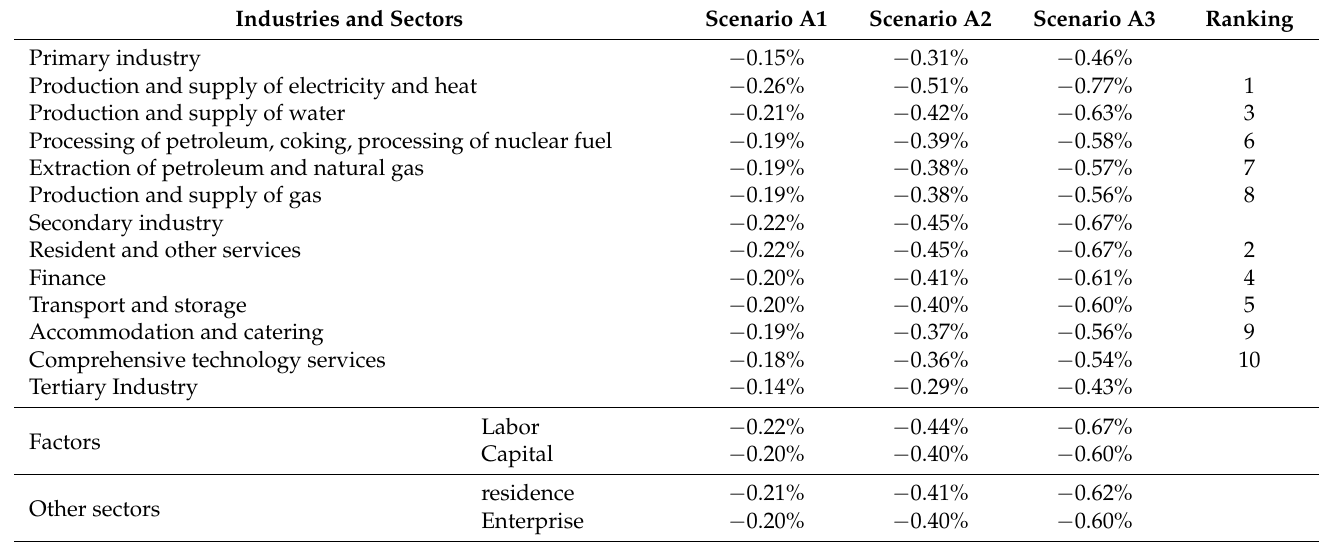
Table 5. Output and income changes of various industries and sectors based on restricting coal